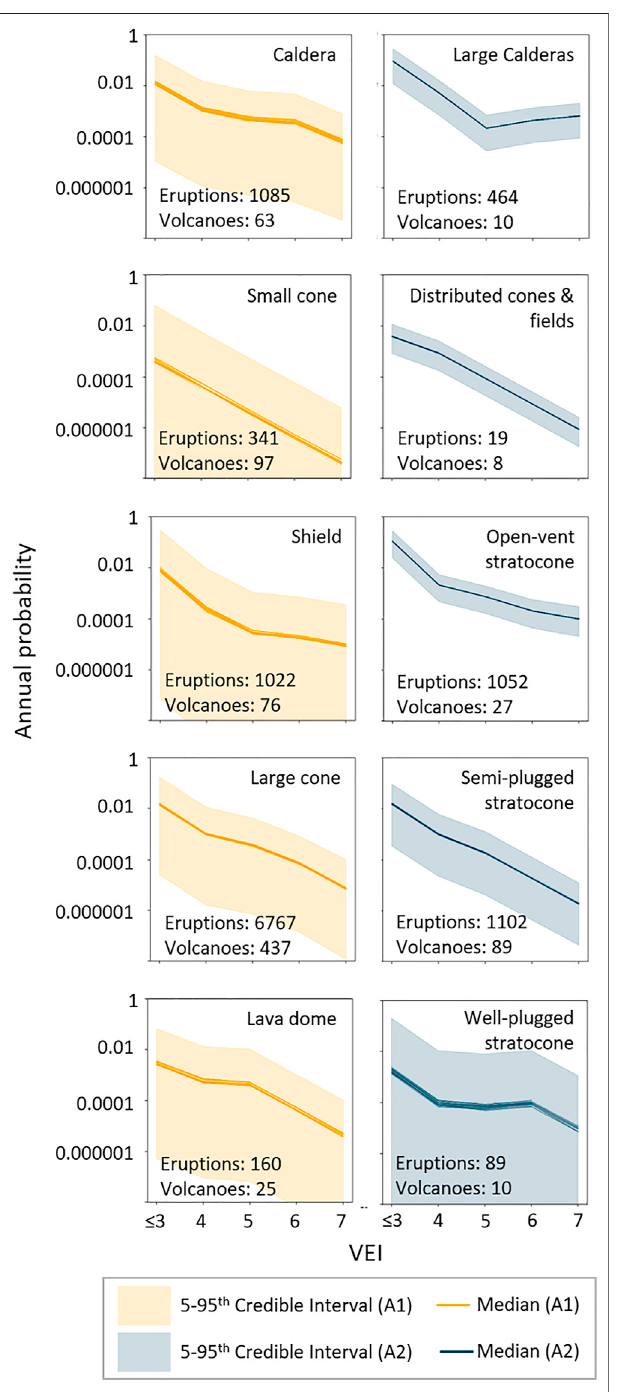
FIGURE 8 | Prior models for each analogue classi fi cation system, with the number of volcanoes and eruptions for each analogue class (A1 system based on criteria from Jenkins et al., 2012 & A2 system from Whelley et al., 2015). Large uncertainty can be observed across many of the analogue classes, especially for those with limited data (i.e., lava dome, well-plugged stratocone, small cone). Note: VEI are discrete data presented as continuous data to emphasize the relationship between VEI and annual probability. See Supplementary Material 3 for the Alpha and Beta parameters.